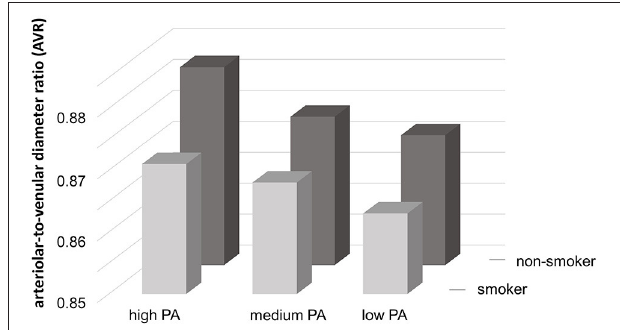
FIGURE 2 | Interrelation between AVR and parental physical activity categories and smoking status. PA, physical activity.